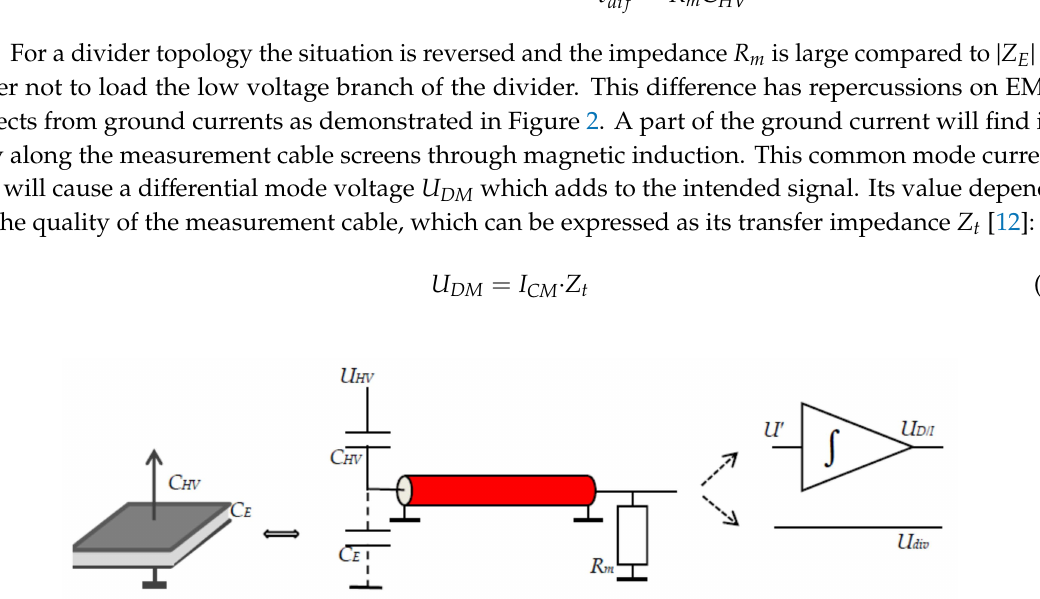
Figure 1. Measurement topologies for D / I and divider methods. Component values for D / I are such that the receiving cable end represents the time derivative of phase voltage U HV and the waveform is restored by integration (the open-air sensor design is shown on the left); For standard dividers this signal directly represents the phase voltage U HV